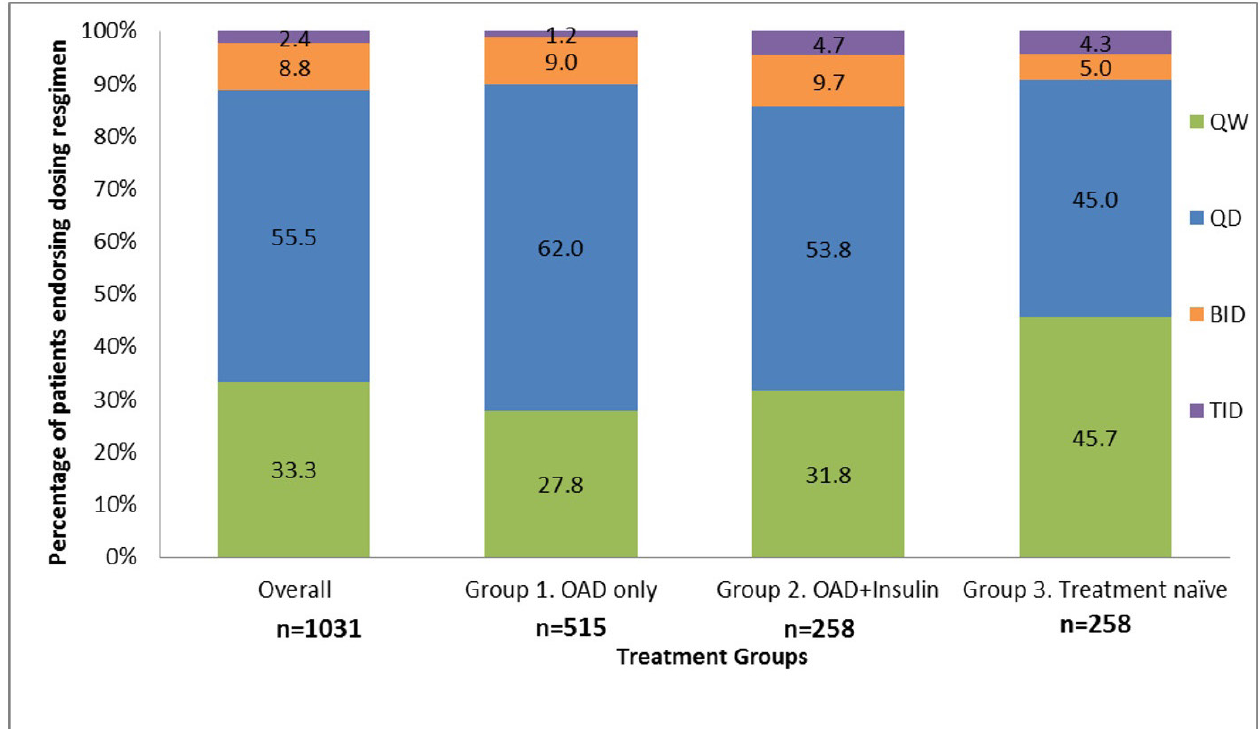
Figure 1. Frequency of Dosing Preference by Groups 1-3 and